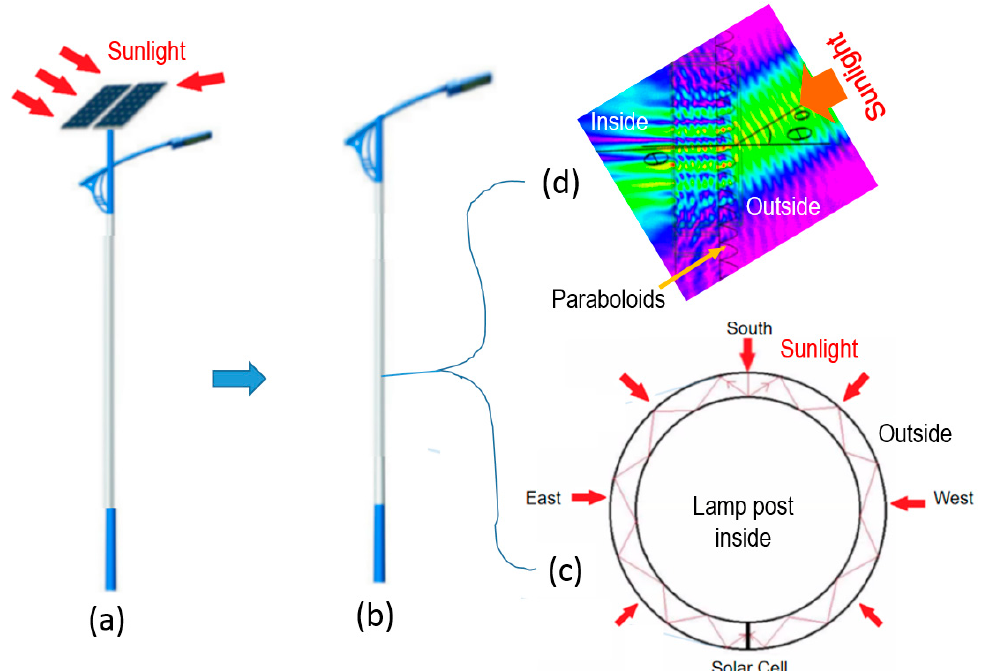
Figure 1. ( a ) Conventional solar streetlamp; ( b ) new type of streetlamp proposed with cylindrical thin waveguide; ( c ) cross-section of the lamppost when sliced across a horizontal plane; ( d ) result of optical simulation of PDC consisting of densely packed paraboloids. The PDC is applied to the surface of the 2D waveguide on the side of the lamppost. Note that this result corresponds to the case when the lamppost is sliced across a vertical plane. The red arrow shows the propagation of sunlight.